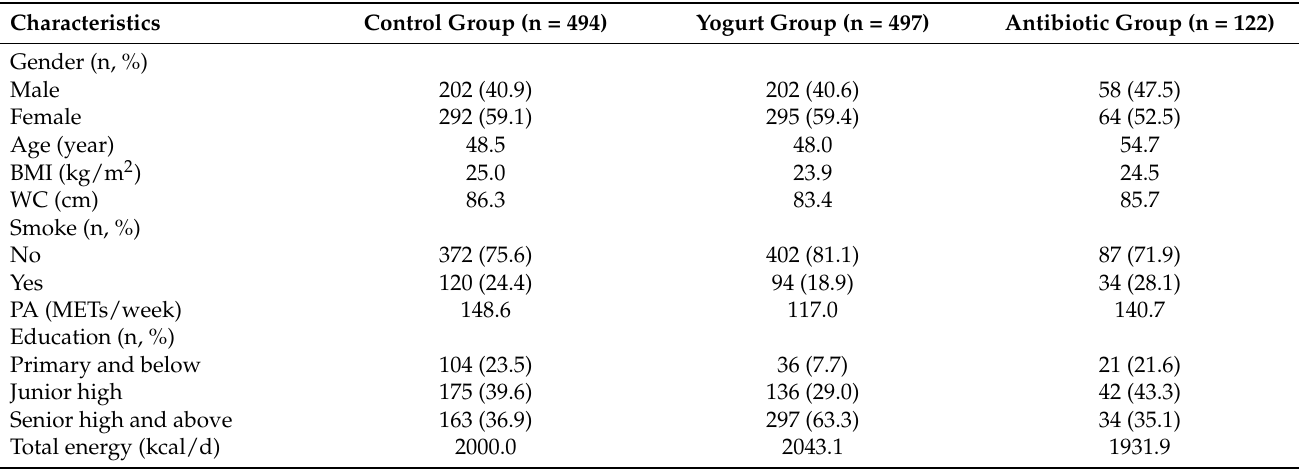
Table 1. Baseline characteristics of adults in different